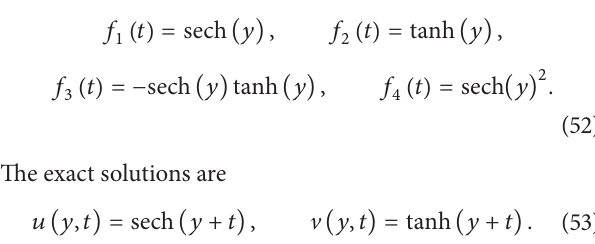
Figure 3: The approximate ̃𝑢 and the exact 𝑢 solutions for different values of 𝑡 = 0.1 , 0.5, and 1.0 of problem (45), where 𝑁 = 16 and 𝛼 = 𝛽 = 0 in the interval [−𝜋,𝜋] .